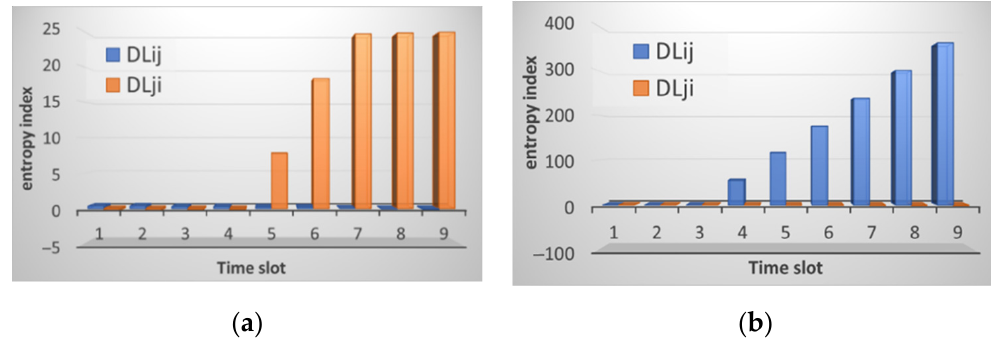
Figure 10. The result of calculating the entropy for: ( a ) received packets; and ( b ) sent packets by node i relative to node j (marked in blue) and node j relative to node i (marked in orange) under conditions of a SYN flood attack.